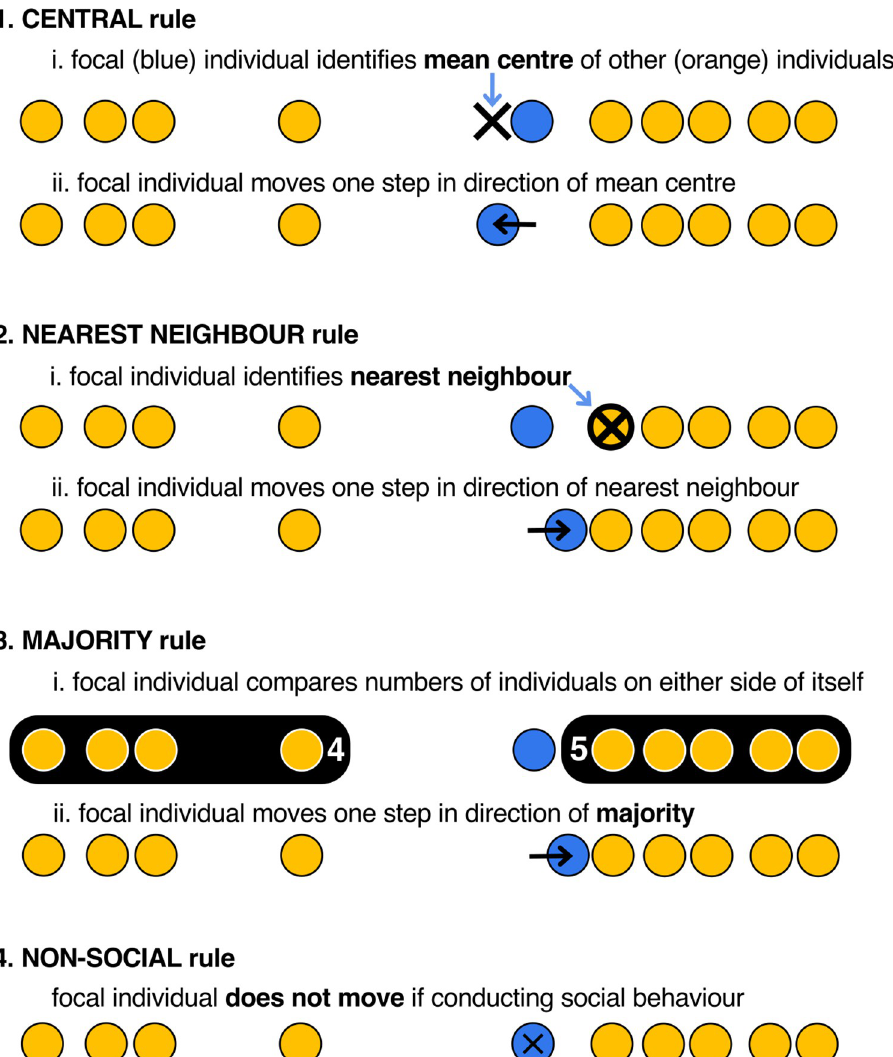
Fig 2. Sketches of the four social interaction rules. Each simulation only considers a single rule, which all individuals follow when they choose to socially